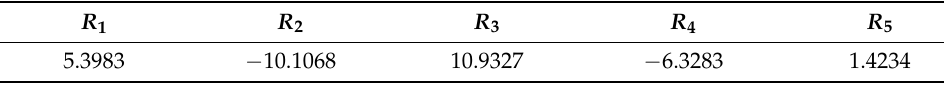
Table 1. E/CRC erosion model constants.